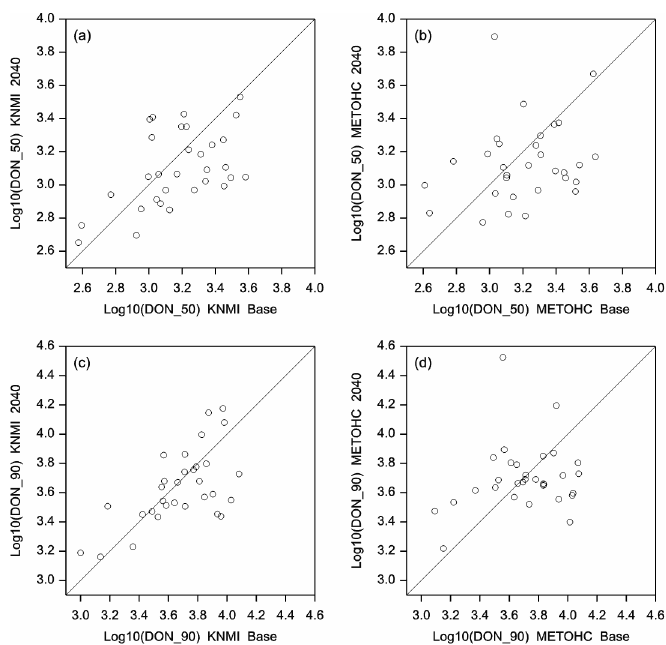
Figure 4. Estimated future DON concentration. Estimated DON concentration (log transformed, in μg kg -1 ) in the future scenario period (2031-2050) relative to the baseline period (1975-1994) using the KNMI model (left panels) and the HC (right panels) climate model data. DON contamination is expressed in both 50 th and 90 th percentile